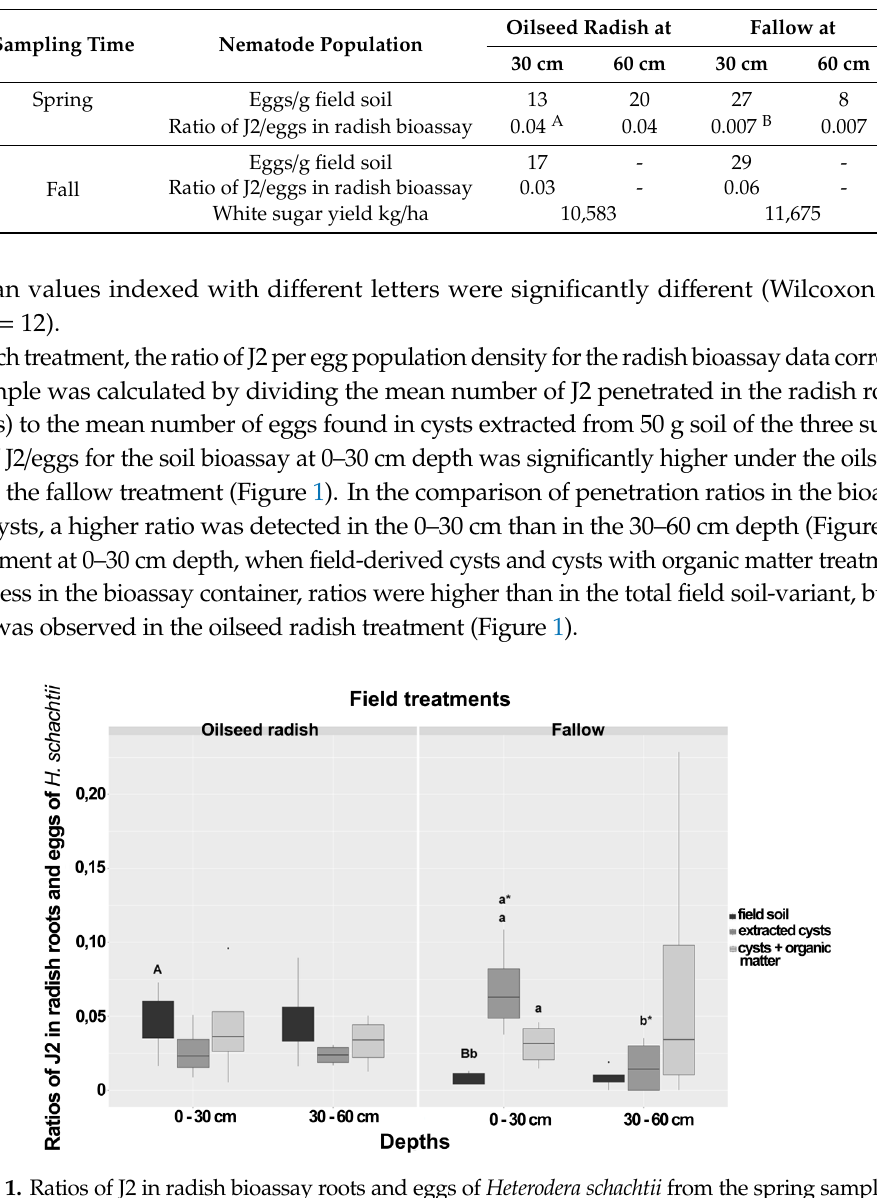
Figure 1. Ratios of J2 in radish bioassay roots and eggs of Heterodera schachtii from the spring sampling at Jeinsen in plots of oilseed radish or fallow treatment at two different depths. Boxes with the same letter, small caps = within each field treatment, small caps with asterisk = between depths within the same treatment, large caps = between groups were not significantly different (Wilcoxon rank test, p < 0.05, n = 12). The asterisk punctuations above the box plot charts refer to the outlier data that markedly deviated from the dataset occurring in each bioassay. The comparison between treatments was carried out at the same depth and type of